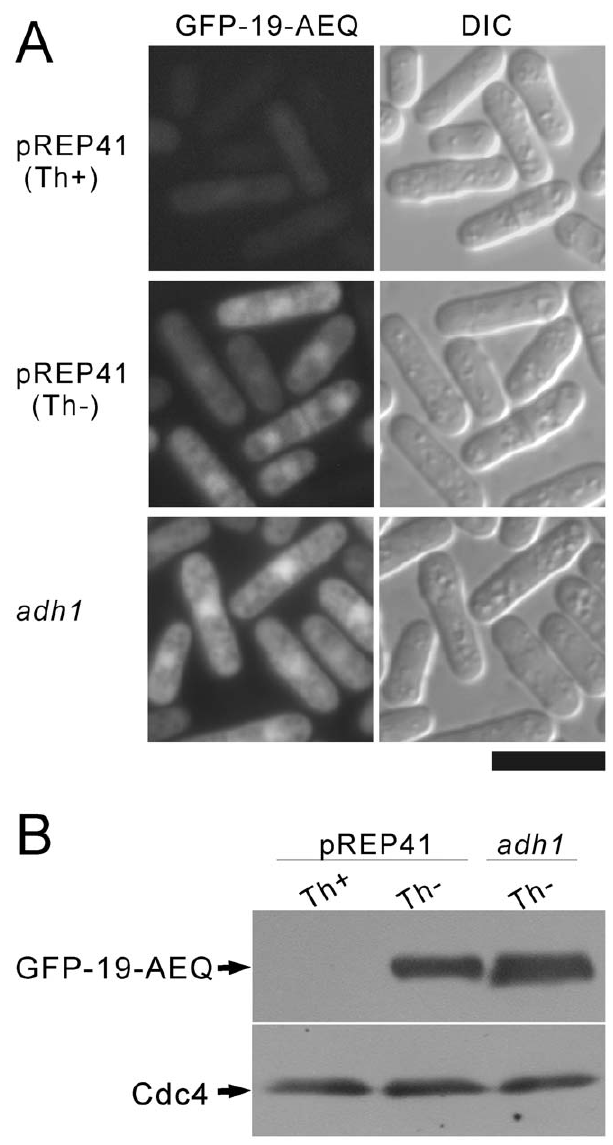
Figure 1. Fluorescence microscopy and immunoblot analysis of GFP-19-AEQ. (A) Fluorescence imaging of GFP-19-AEQ. The pREP41- GFP-19-AEQ (pKB6045) or adh1-GFP-19-AEQ (pKB6892) was trans- formed into the wild-type cells. The transformants were grown to early log phase in EMM with (Th + ) or without (Th-) 4 m M thiamine to repress and to induce the expression of GFP-19-AEQ, respectively. Then,